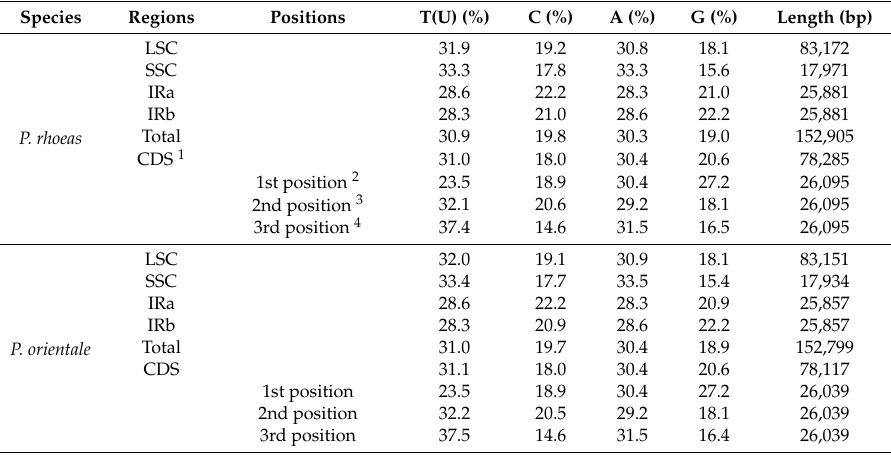
Table 1. Base composition in the chloroplast genomes of P. rhoeas and P. orientale . Species Regions